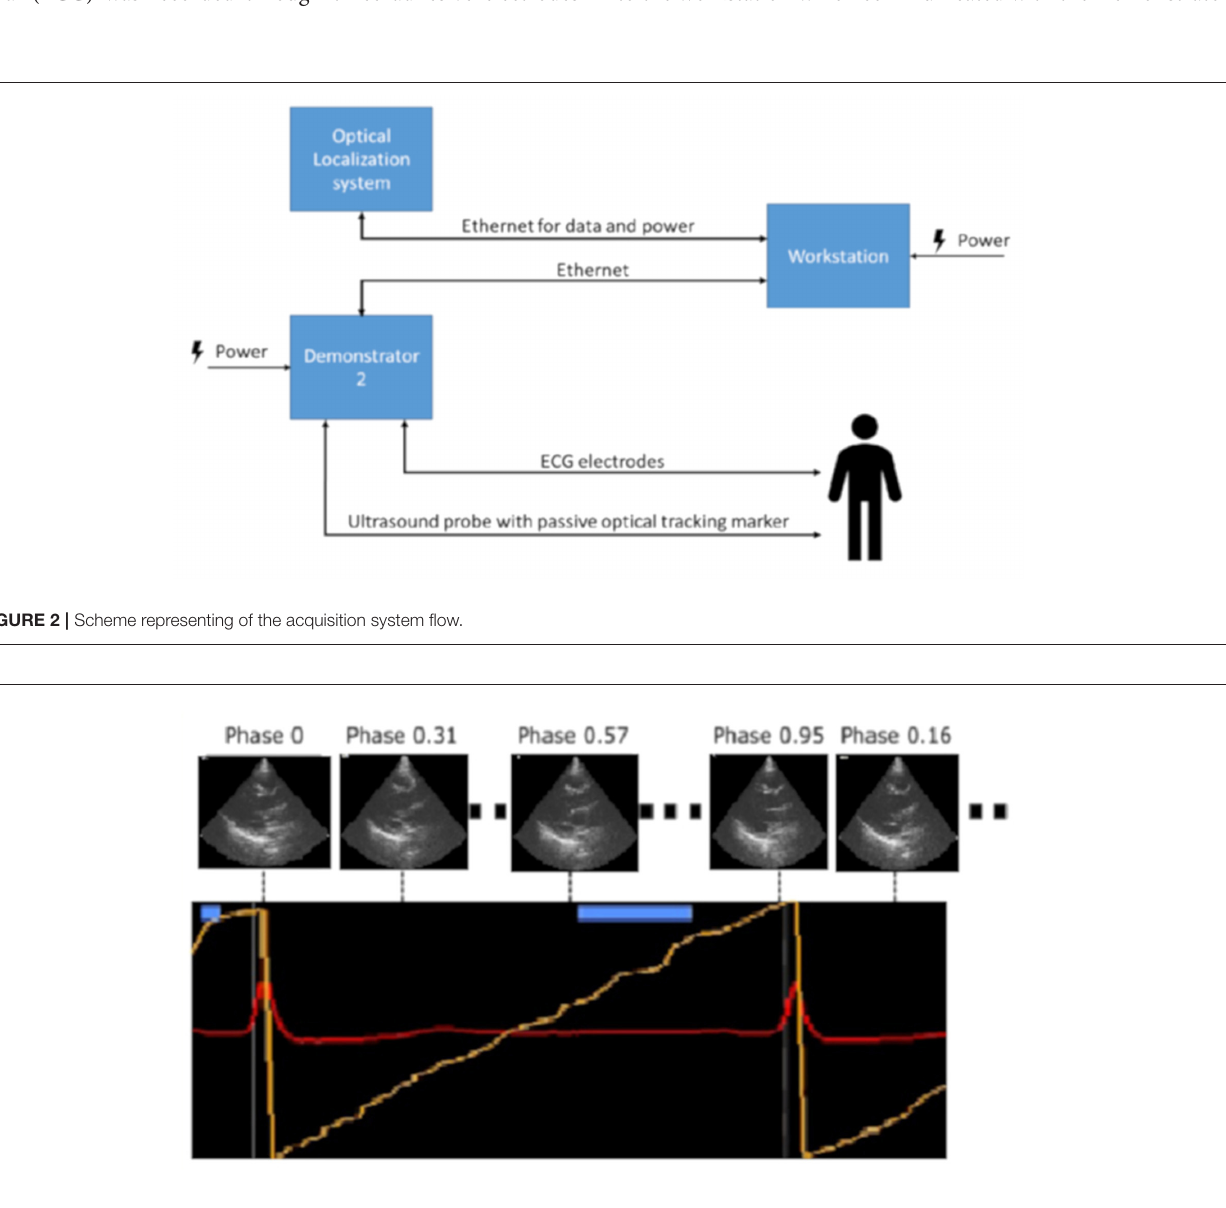
FIGURE 3 | Identification of the cardiac cycle phase performed by the artificial intelligence algorithm through the real-time analysis of the acquired ultrasound images. A linear mapping between 0 and 1 (yellow line) was performed in the R-R peak interval and a cardiac phase was assigned to each ultrasound frame based on its temporal position within this